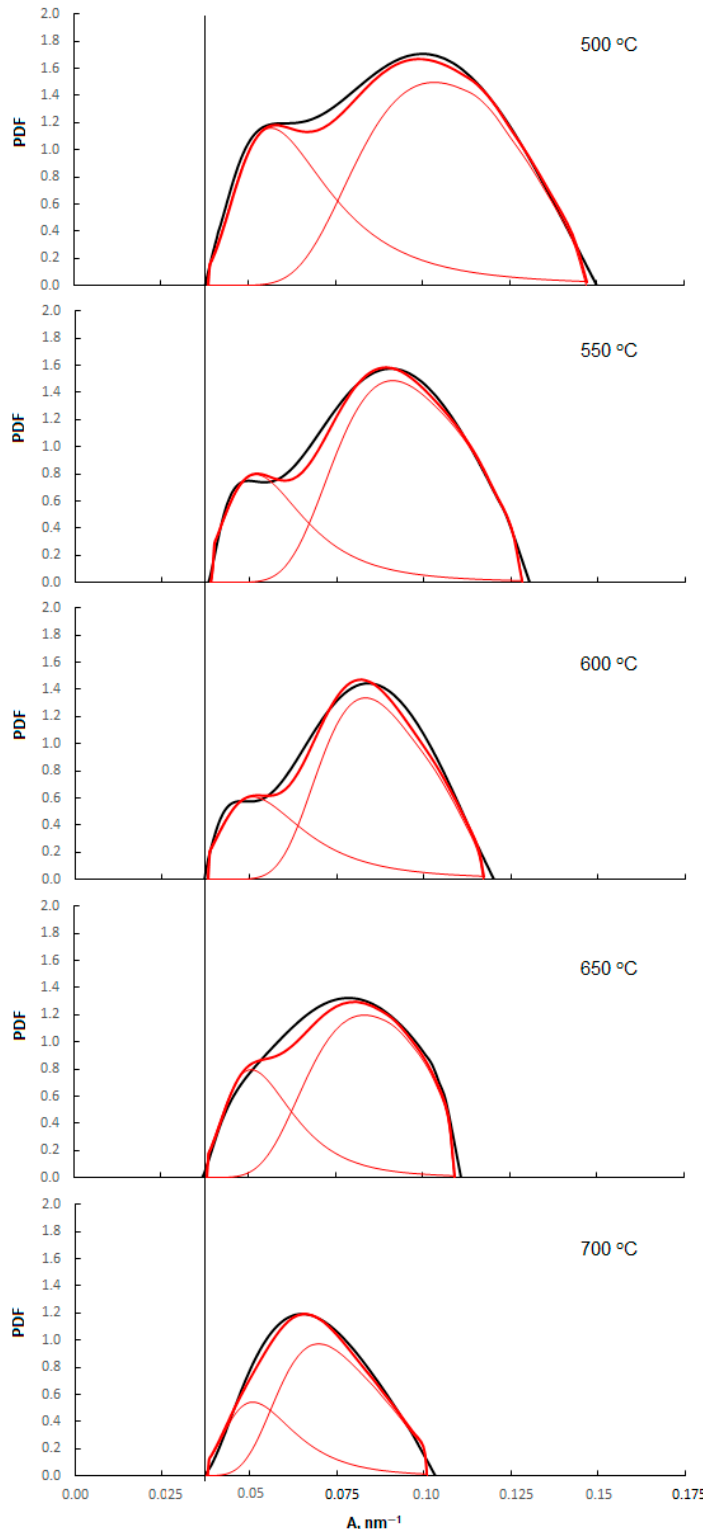
Figure 8. Distribution density probability of active specific surfaces of nanocrystalline iron samples annealed at temperatures in the range of 500–700 °C.